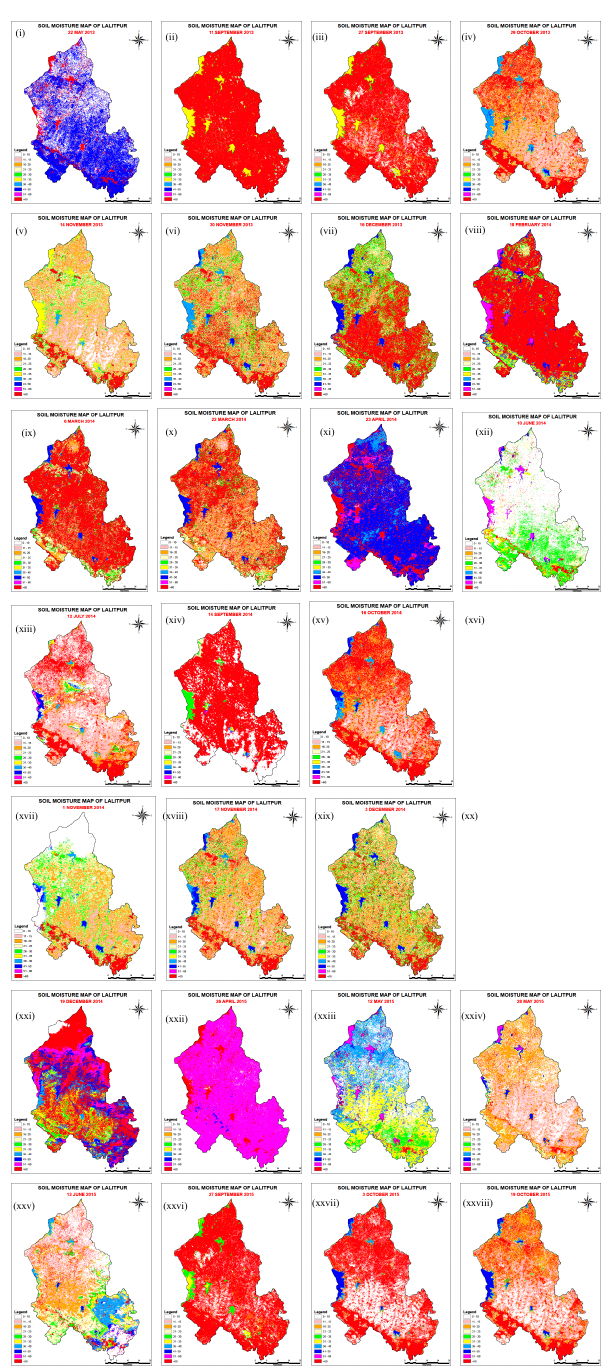
Table 2: Collected soil samples and measured soil